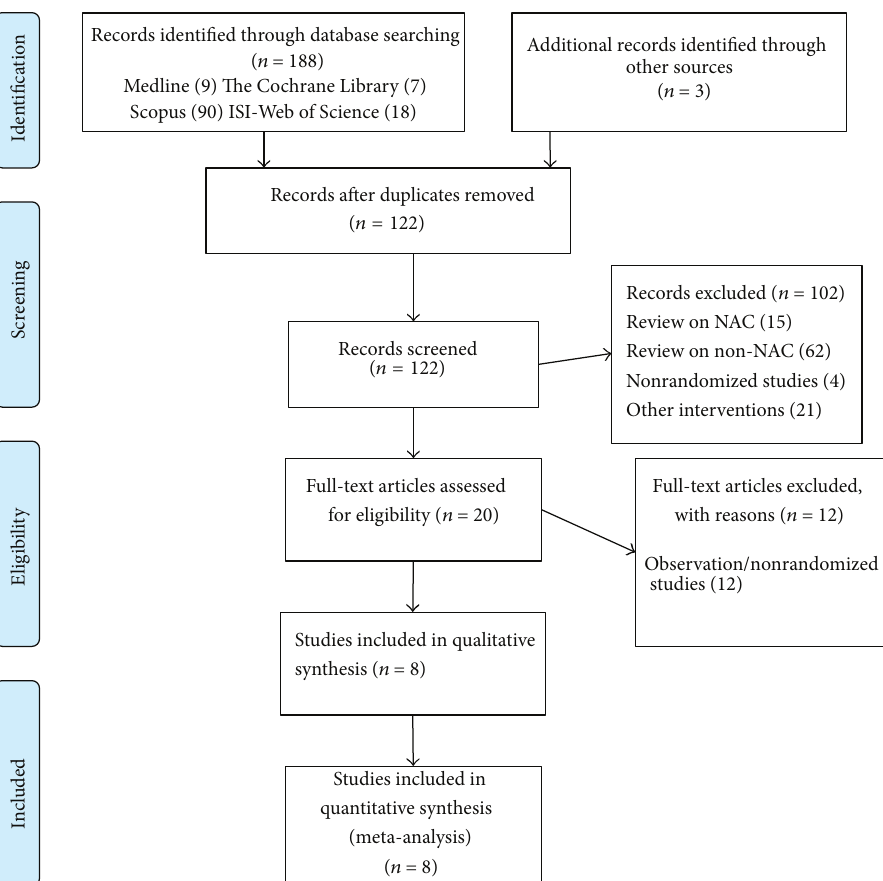
Figure 1: PRISMA flow diagram for selection of studies for the systematic review. Flow diagram style adapted from Moher et al. [12].